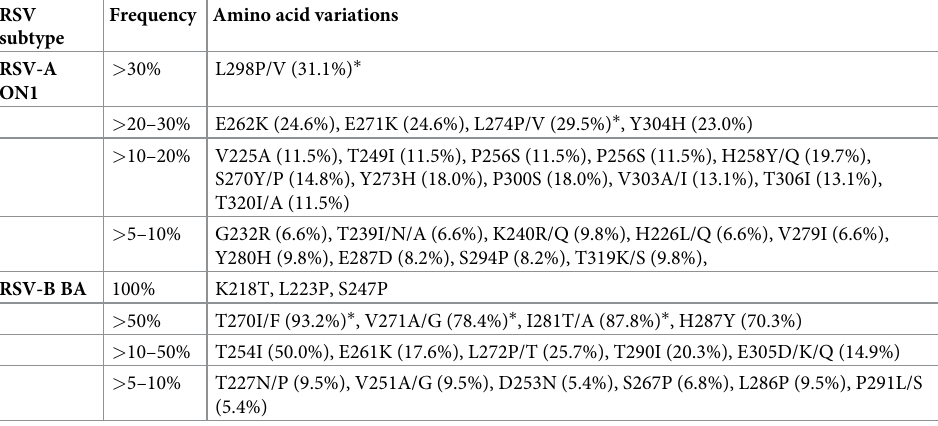
Table 2. Details of amino acid variations in the 2 nd HVR of RSV G gene of Seoul RSV-A ON1 and RSV-B BA